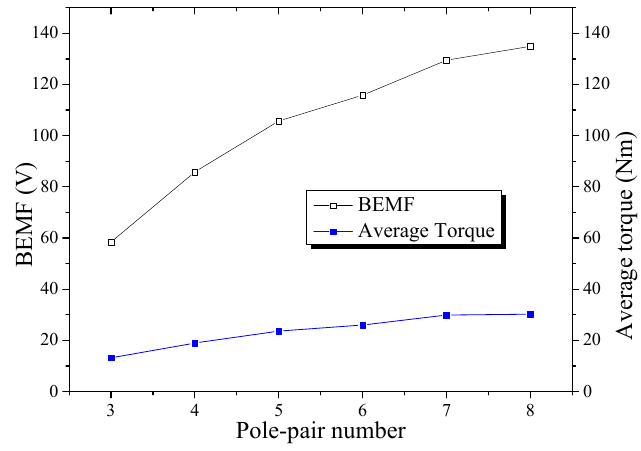
Figure 11. Variation of BEMF and average torque versus pole-pair number.